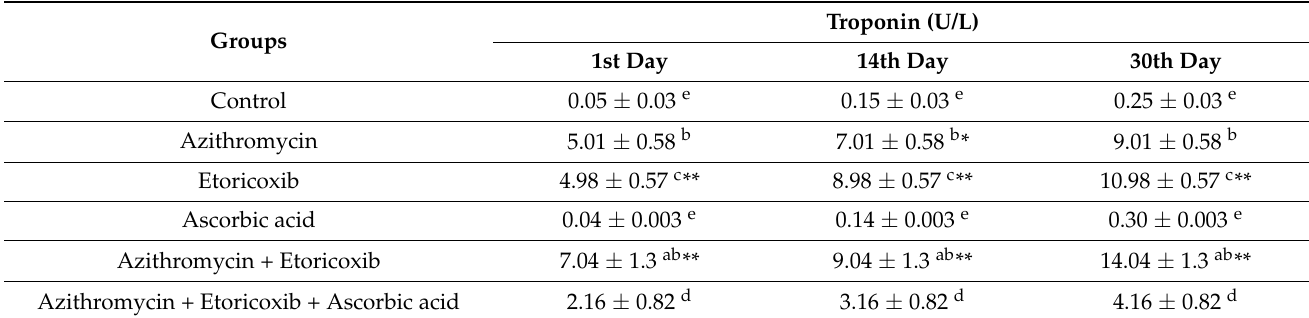
Table 6. Effects of ascorbic acid on heart function marker (troponin) in male rats after 30 days of administration of either azithromycin or etoricoxib or their